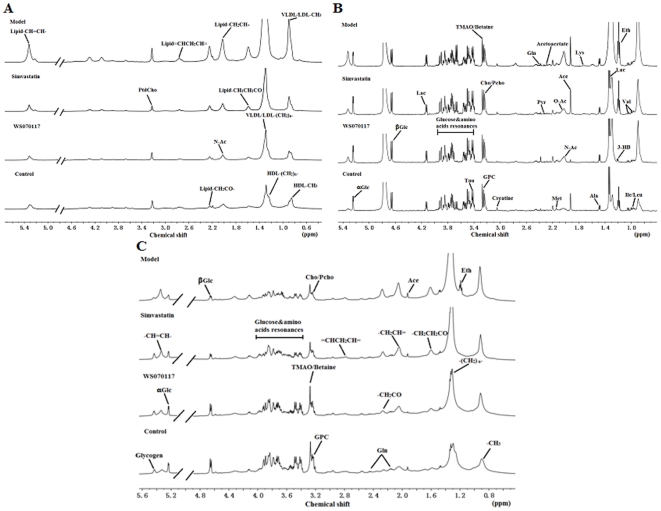
Typical 500 MHz 1H-NMR spectra of hamster plasma and liver samples.(A): 1H-NMR BPP-LED spectra of plasma samples. (B): 1H-NMR CPMG spectra of plasma samples. (C): HR-MAS 1H-NMR standard spectra of liver tissues. Signal assignment: VLDL, very low-density lipoprotein; LDL, low-density lipoprotein; HDL, high-density lipoprotein; PtdCho, Phosphatidylcholine; Ile, Isoleucine; Leu, Leucine; 3-HB, 3-D-Hydroxybutyrate; Val, Valine; Eth, (residual) Ethanol; Lac, Lactate; Ala, Alanine; Lys, Lysine; Ace, Acetate; N-Ac, N-Acetyl glycoproteins; O-Ac, O-Acetyl glycoproteins; Met, Methionine; Pyr, Pyruvate; Gln, Glutamine; Cho, Choline; GPC, Glycerophos- phorylcholine; Glc, Glucose; TMAO, Trimethylamine-N-oxide.